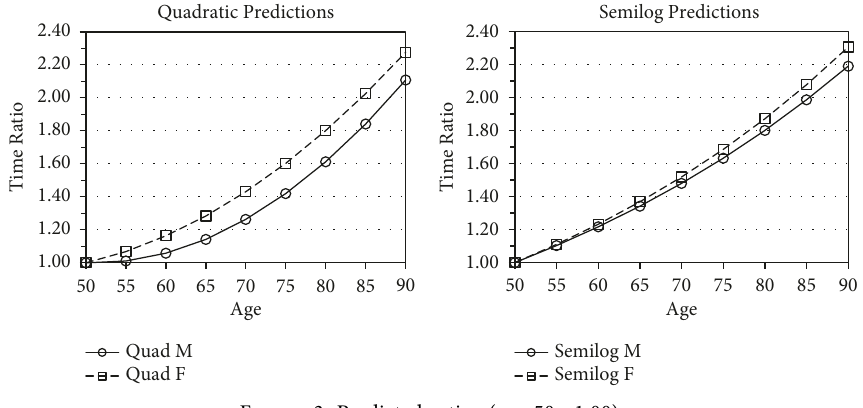
Figure 3: Predicted ratios (age 50 �